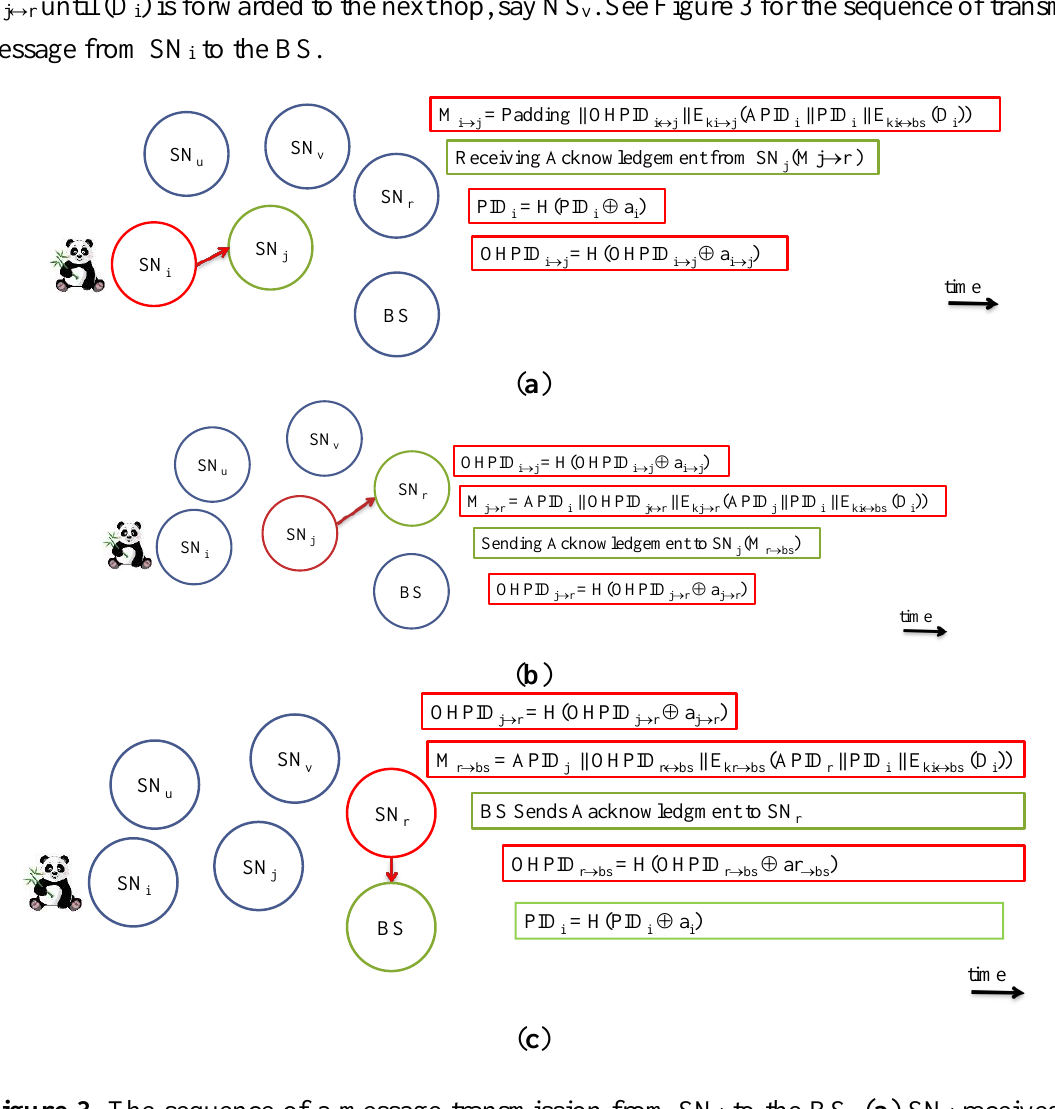
Figure 3. The sequence of a message transmission from SN i to the BS. ( a ) SN j receives a message from SN i ; ( b ) SN j forwards the message to a neighbor SN r ; ( c ) BS receives the message and processes